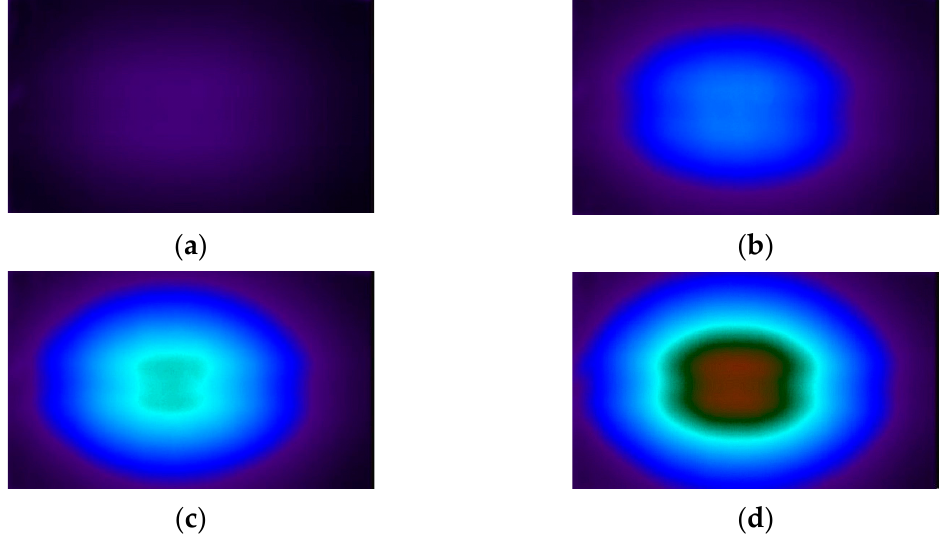
Figure 8. Laboratory-scale setup: temperature distribution on the sheet using a trough ceramic heater with 500 W maximum power consumption at ( a ) t = 15 s; ( b ) t = 30 s; ( c ) t = 45 s; ( d ) t = 60 s. Considering the small distance between the sheet and heating element, furthermore, because of the use of reflectors behind each heater, we assume that all the radiation from the heating coil that is located in the center of the thermoplastic sheet (Heater number 8 in Figure 6b) strikes the surface of the sheet. Some thermoplastics, such as polycarbonate and acrylic, are highly transparent, while PVC and ABS are opaque. Since an opaque acrylic thermoplastic sheet loaded with a specific amount of pigment is used in our experiment (Figure 6a), all infrared emissions are considered either reflected ( ρ r ), or absorbed ( α a ) by the thermoplastic sheet (Figure 9). There is a straightforward relationship between these two variables according to equation 13 that totals 1 or 100 percent. For a black surface, which absorbs all incoming radiation and emits the maximum possible, α a = 1 and ρ r = 0 [36].